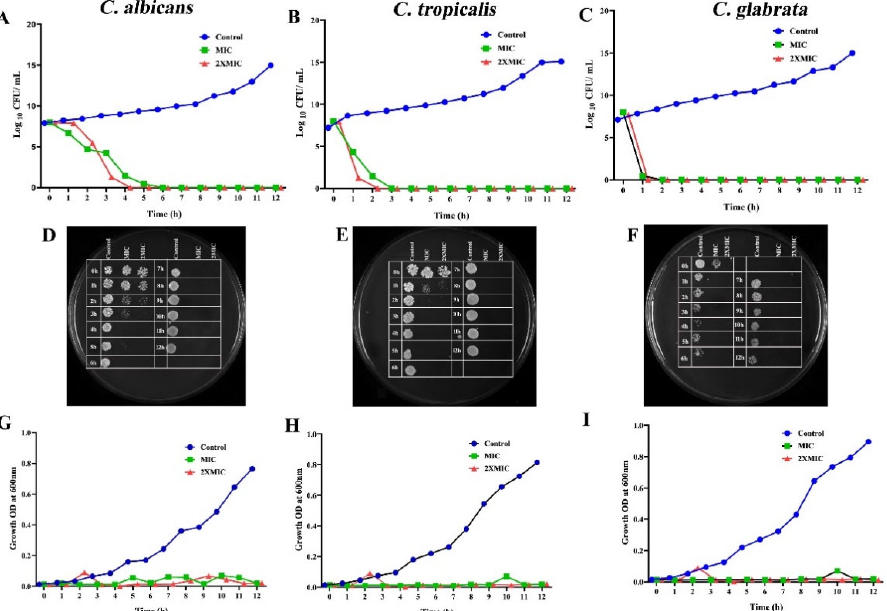
Figure 3. Time–kill kinetics of different concentrations of CTAC (MIC and 2XMIC) according to planktonic growth of tested Candida strains. ( A – C ) Graph plotted by comparing CFU/mL of fungal strains to duration of CTAC exposure. ( G – I ) Time–kill kinetics graph plotted by considering growth OD of fungal strains compared to duration of CTAC exposure. The fungal strain devoid of compound served as growth control. ( D – F ) Killing ability of CTAC over time was authenticated by the spot method.